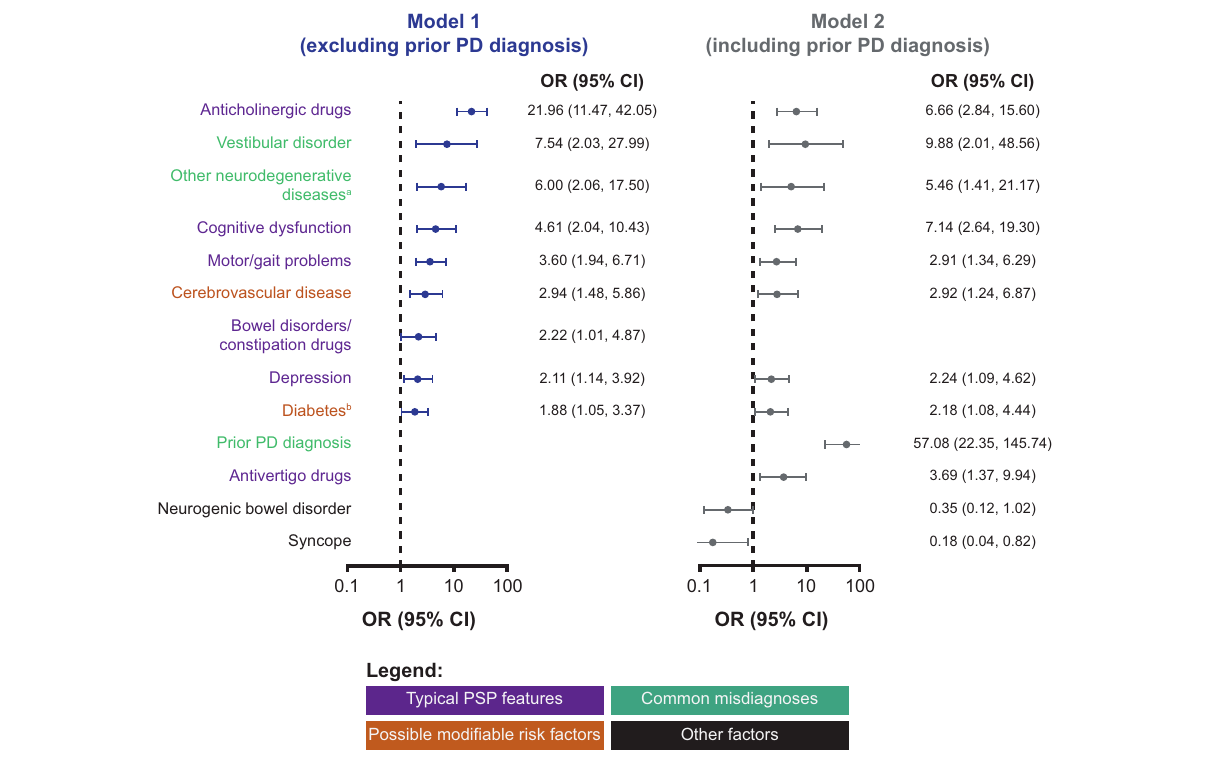
FIGURE 3 | Relative effects of clinical features associated with subsequent PSP diagnosis according to multivariate models. a Neurodegenerative diseases other than PD or PSP. b Including both type 1 and type 2 diabetes, although the majority of patients with PSP had diabetes mellitus (see Figure 2 ). CI, confidence interval; OR, odds ratio; PD, Parkinson’s disease; PSP, progressive supranuclear